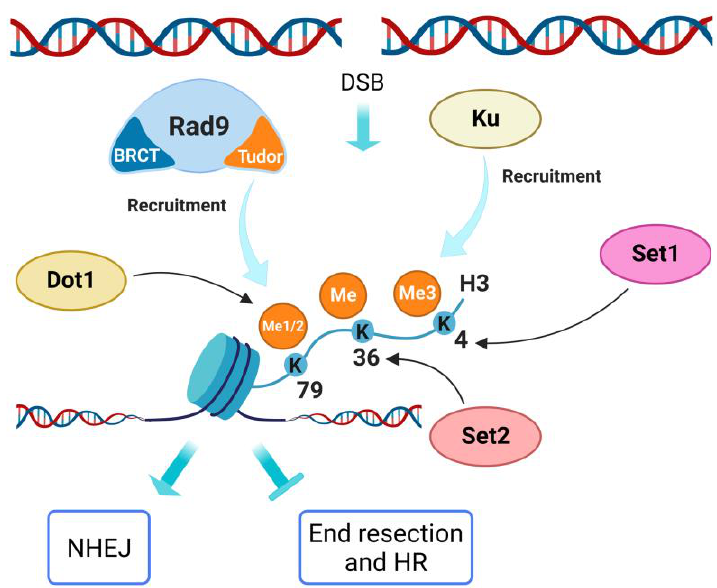
Figure 4. Methylation of histone H3 promotes NHEJ in S. cerevisiae . Set1-dependent tri-methylation of H3 K4 residue stimulates an efficient recruitment of Ku to the DSB ends. Set2-dependent methylation of H3 K36 likely limits DNA end resection and chromatin accessibility. Dot1-dependent methylation of H3 K79 is crucial for Rad9 recruitment, which inhibits DSB end resection. Created with BioRender.com.